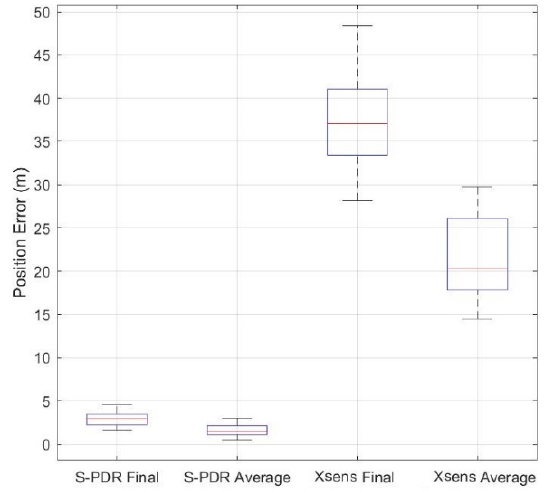
Figure 24. Boxplot of the errors of S-PDR vs. Xsens for outdoor test.